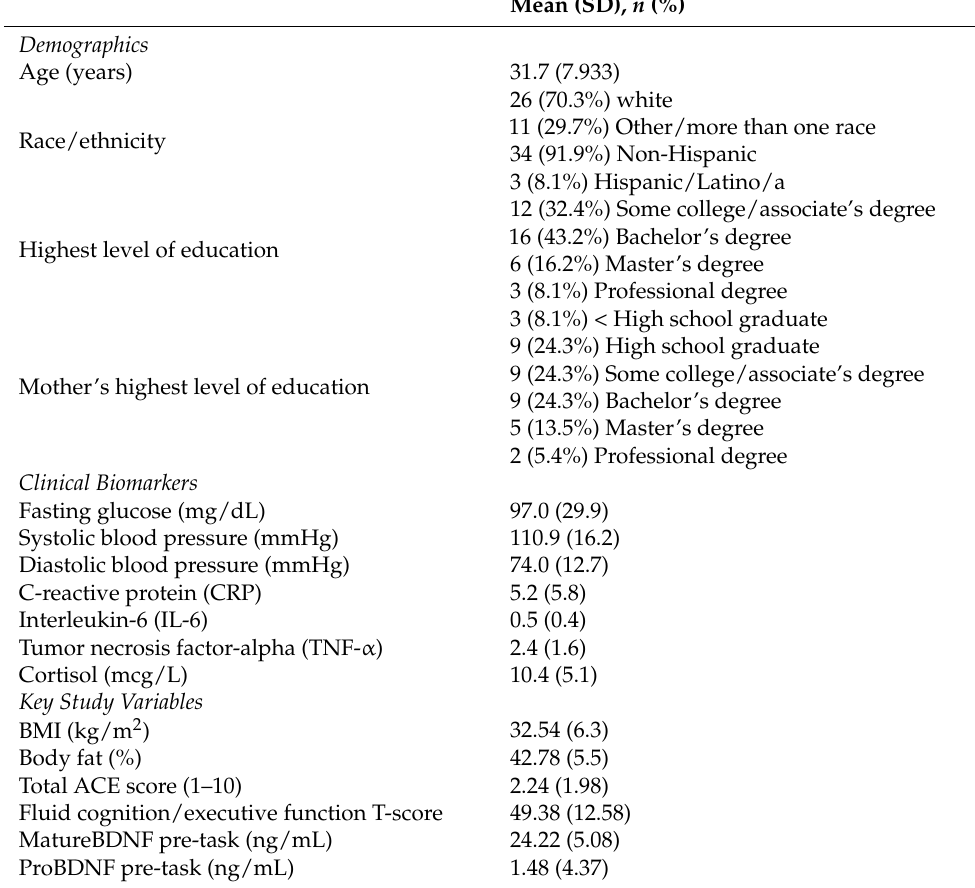
Table 1 as indicators of the health of the sample: fasting glucose, blood pressure, C-reactive protein, interleukin-6, tumor necrosis factor-alpha, and cortisol. Table 1. Participant Demographics, Clinically Relevant Biomarkers, and Key Study Variables ( n =